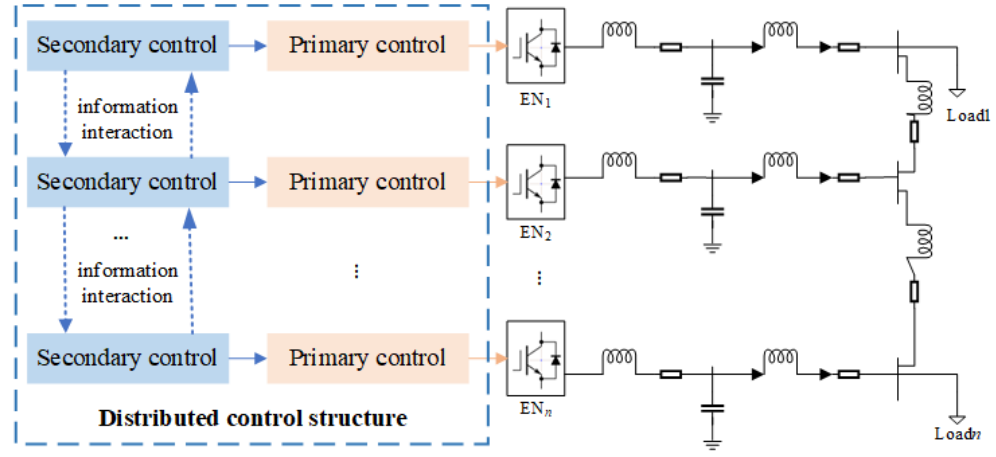
Figure 2. Distributed scheme for secondary voltage